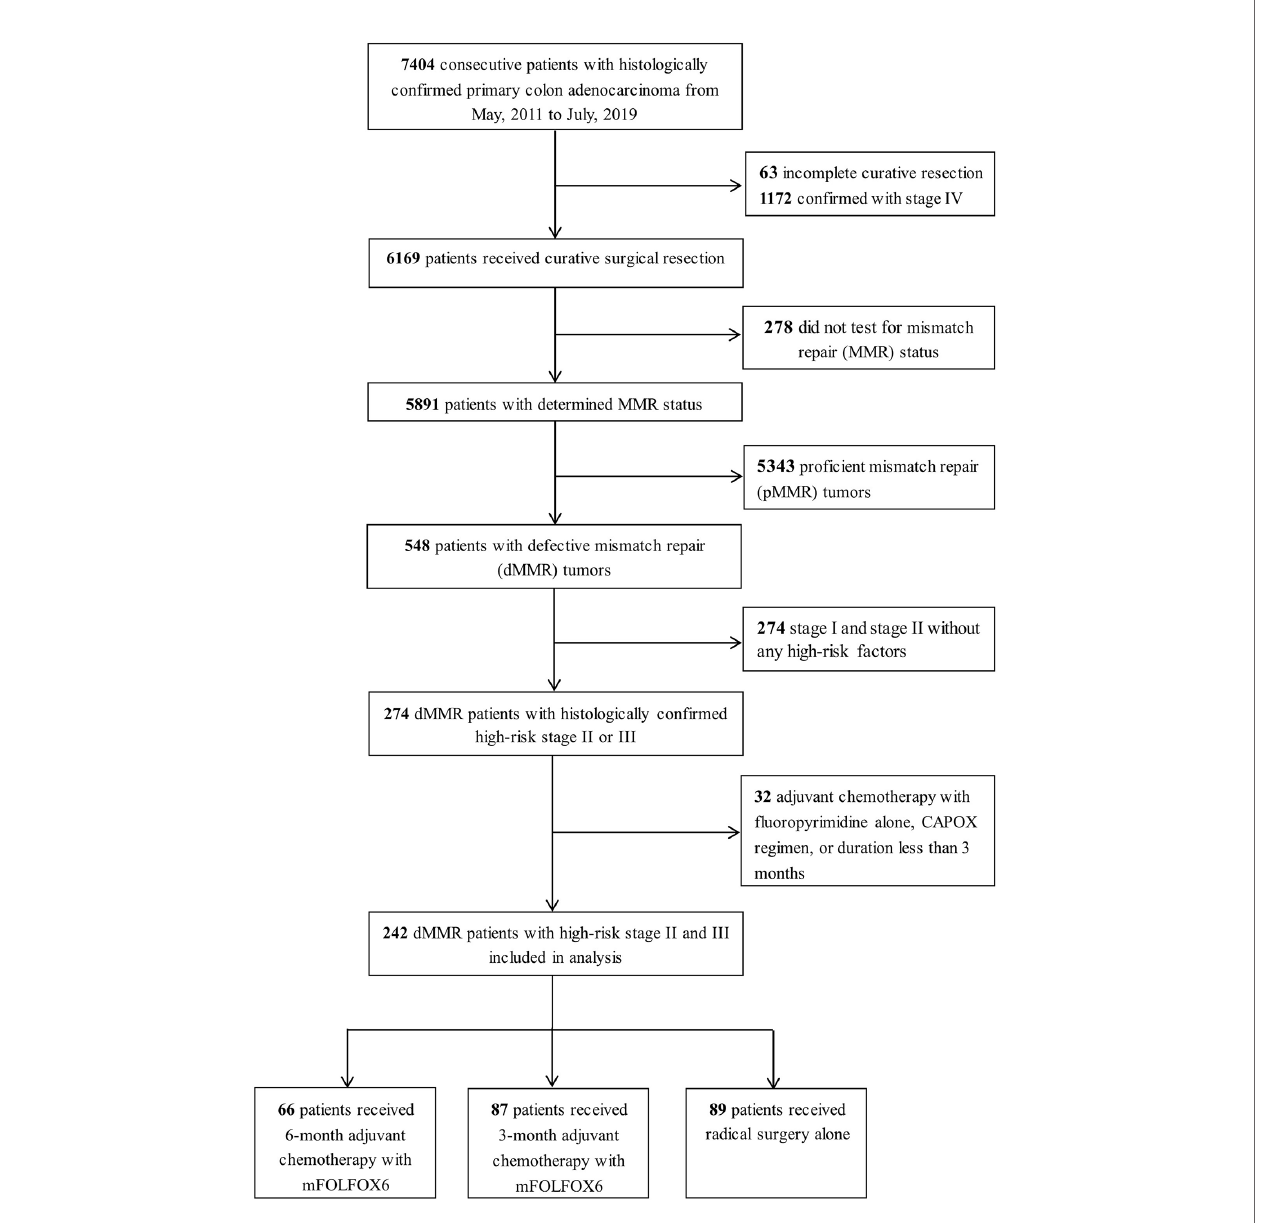
FIGURE 1 | Flow diagrams of the study